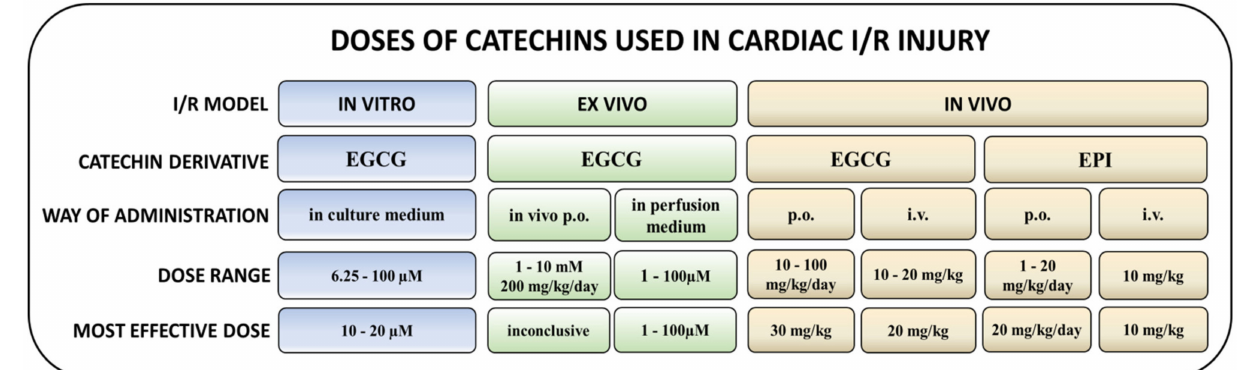
Figure 5. Catechin dosages used in preclinical studies of myocardial I/R